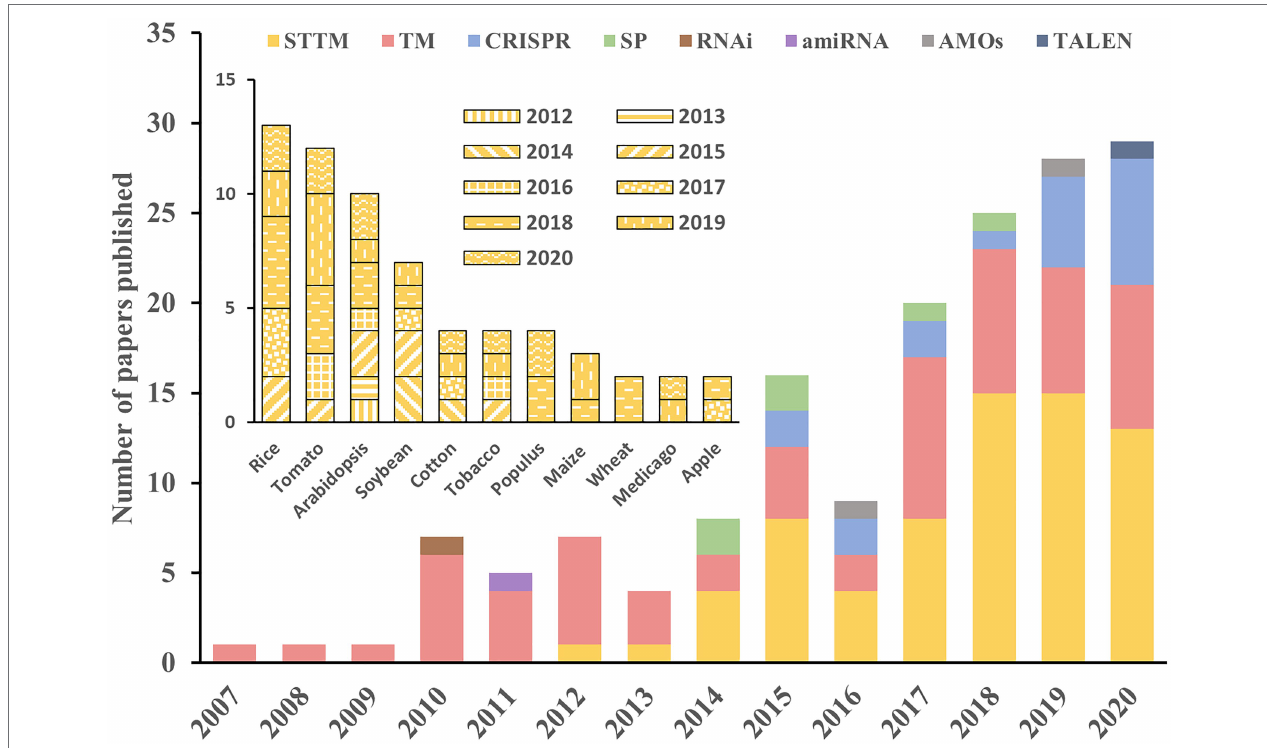
FIGURE 3 | Applications of different approaches in the literature. The histograms show the number of manuscripts published per year using the different approaches for miRNA study in plants (outer) and the application of STTM in different species (inner). The information used in this figure was retrieved through April 30, 2021, from